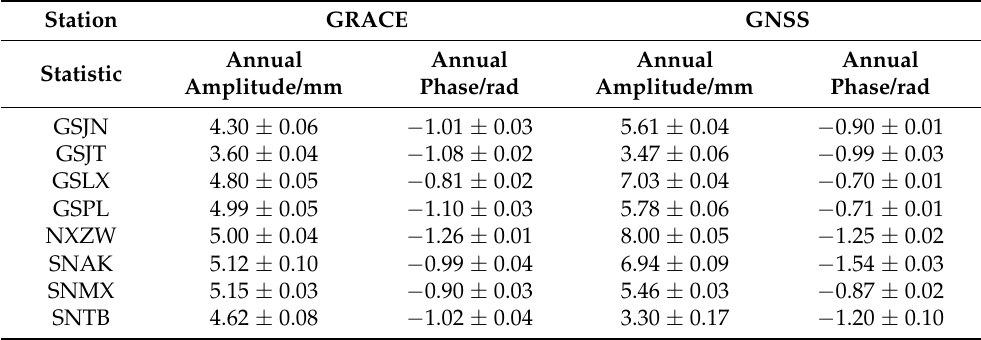
Table 4. Statistical values of the vertical deformation from GNSS and the sum of GRACE and GAC in SGN from 2010 to